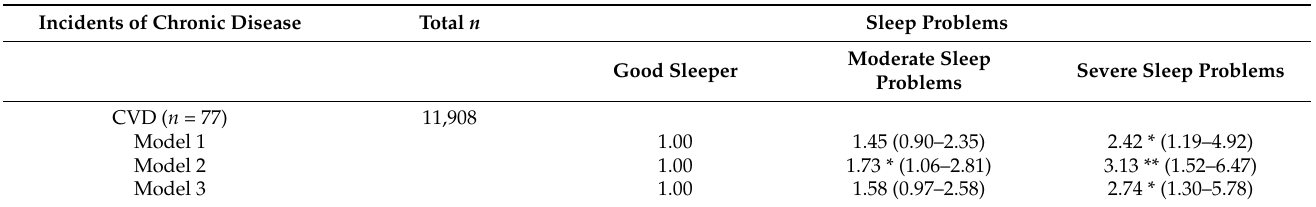
Table A2. Odds ratios (95% Confidence Intervals) for incidents of chronic disease according to the level of sleep problems over 15 months during the COVID-19